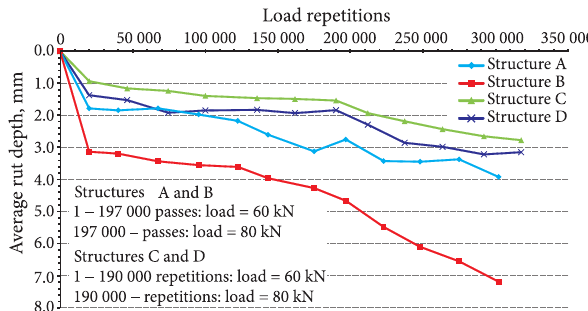
Fig. 4. Development of average rut depth, mm